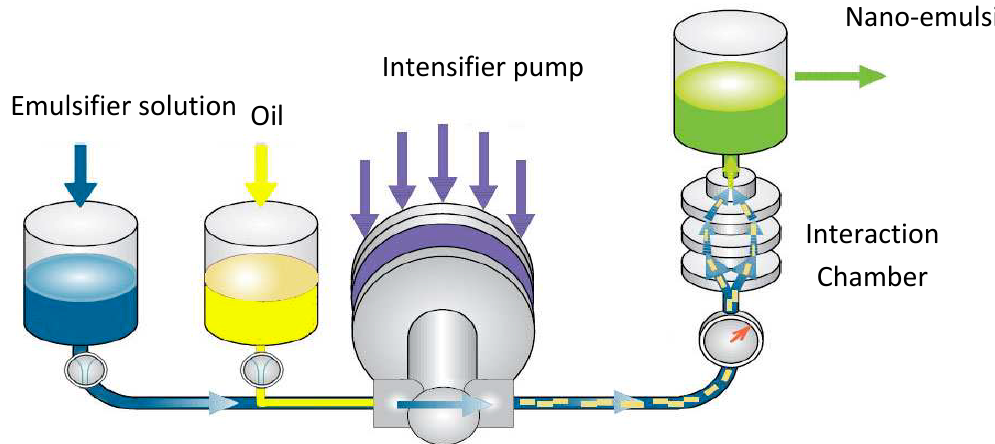
Figure 5. Microfluidics’ processor configuration for bottom-up